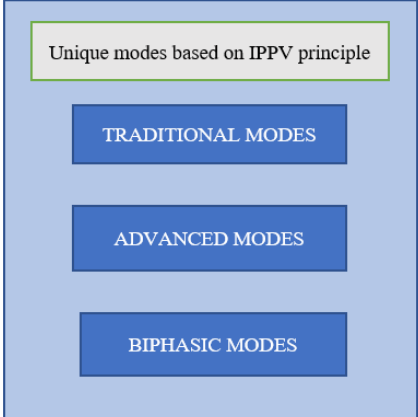
Figure 2. Major classification of ventilation modes.